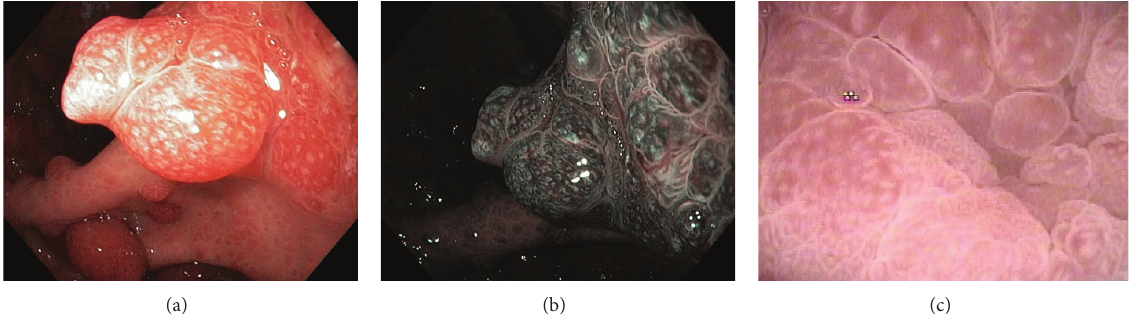
Figure 4: Stomach. Strawberry-like polyps, (a) high resolution white light endoscopy, (b) narrow band imaging (NBI), (c) zoom.